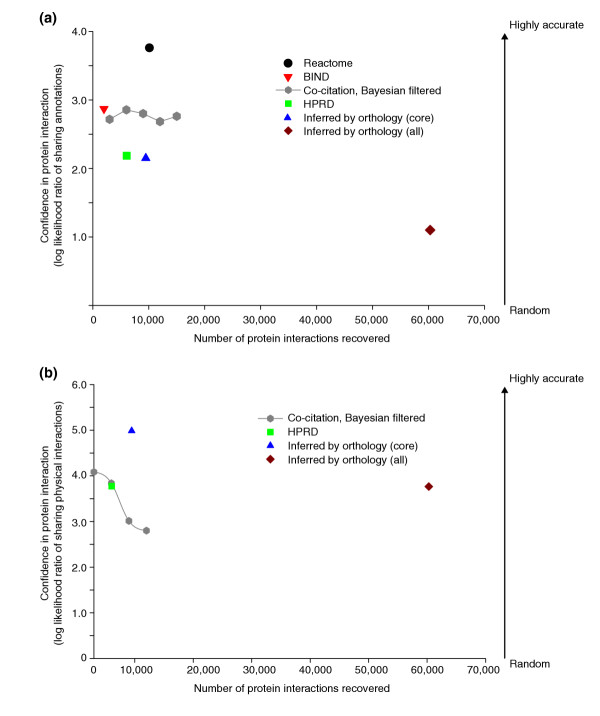
A comparison of the available human protein interaction data on the two benchmarks. (a) An examination of the initial performance of the datasets on the functional annotation test benchmark reveals the relative quality of each dataset. The interactions extracted using co-citation analysis filtered by the Bayesian estimator show a robust behavior in terms of their scores. (b) Comparison of the performance of the interactions retrieved from the co-citation analysis after incorporating the Bayesian filter and the interactions from HPRD and orthology transfer, as assessed on the physical interaction benchmark. The Bayesian filter effectively ranks the co-citation-derived interactions in terms of their correspondence to physical protein interactions.